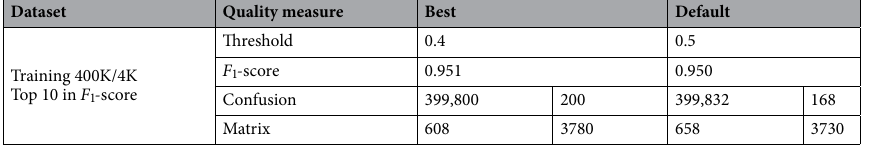
Table 8. Performance of synthetic traffic generated by standard WGANs by sampling generators with elitism among the top 10 models in training sorted by F 1 -score. Results on testing.